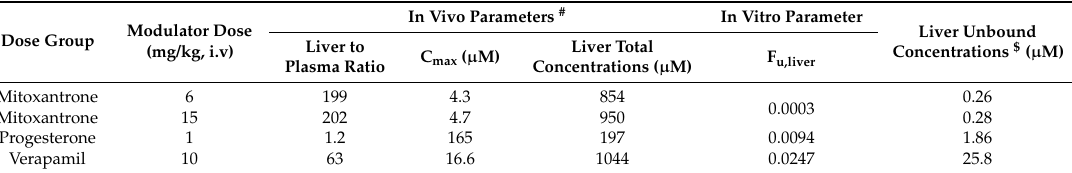
Table 2. Liver unbound concentrations of